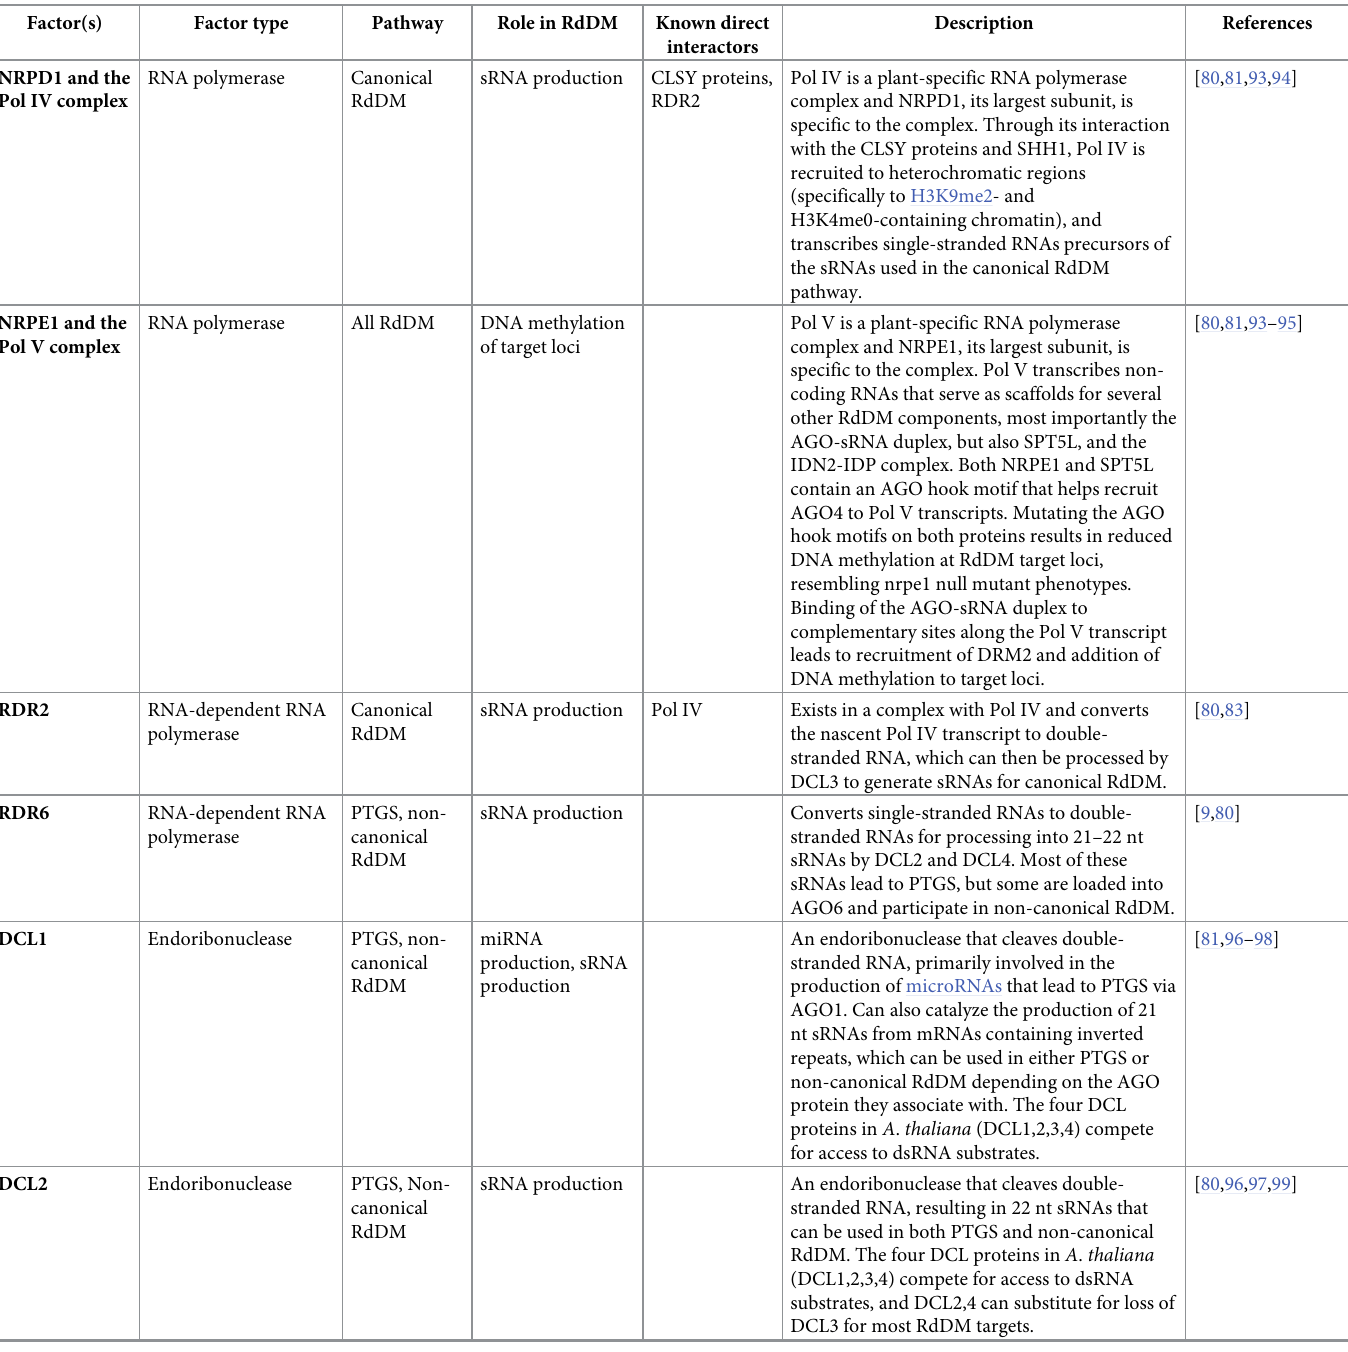
Table 1. Factors involved in